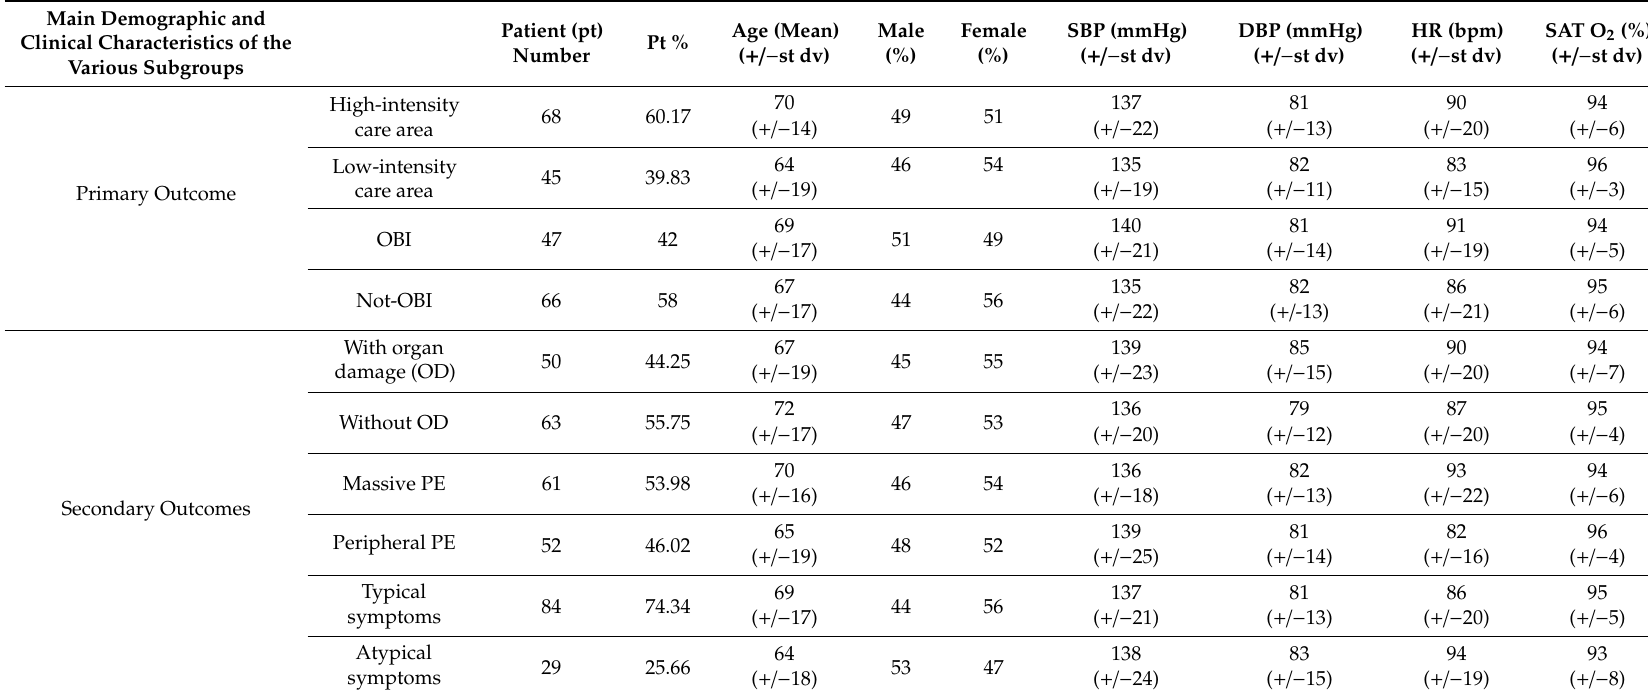
Table 1. The main demographic and clinical characteristics of the various subgroups analyzed. At the top, the analytic subgroups for the primary outcome. Below, the subgroups analyzed in the secondary